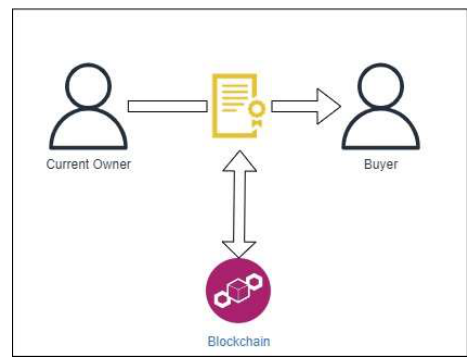
Fig 2: Transfer of ownership and transaction details are stored in blockchain